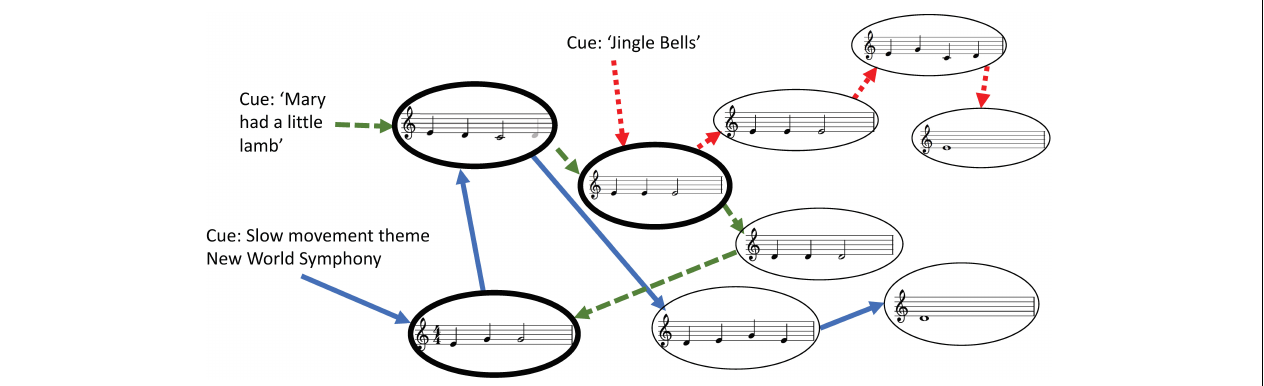
FIGURE 1 | Illustration of veridical chaining, showing music fragments (rhythmically simplified and transposed to C major) parsed into nodes (shown as ovals) and combined through a chaining process. Arrows indicate the chaining links at each temporal step (each color/pattern arrow represents a step in one of the three pieces of music). That is, when the first arrow, cued by the name of the piece of music, activates its target node, the arrow exiting that node primes the next node until the current node has played, and so on. Thick oval nodes indicate those that have been reused in the examples